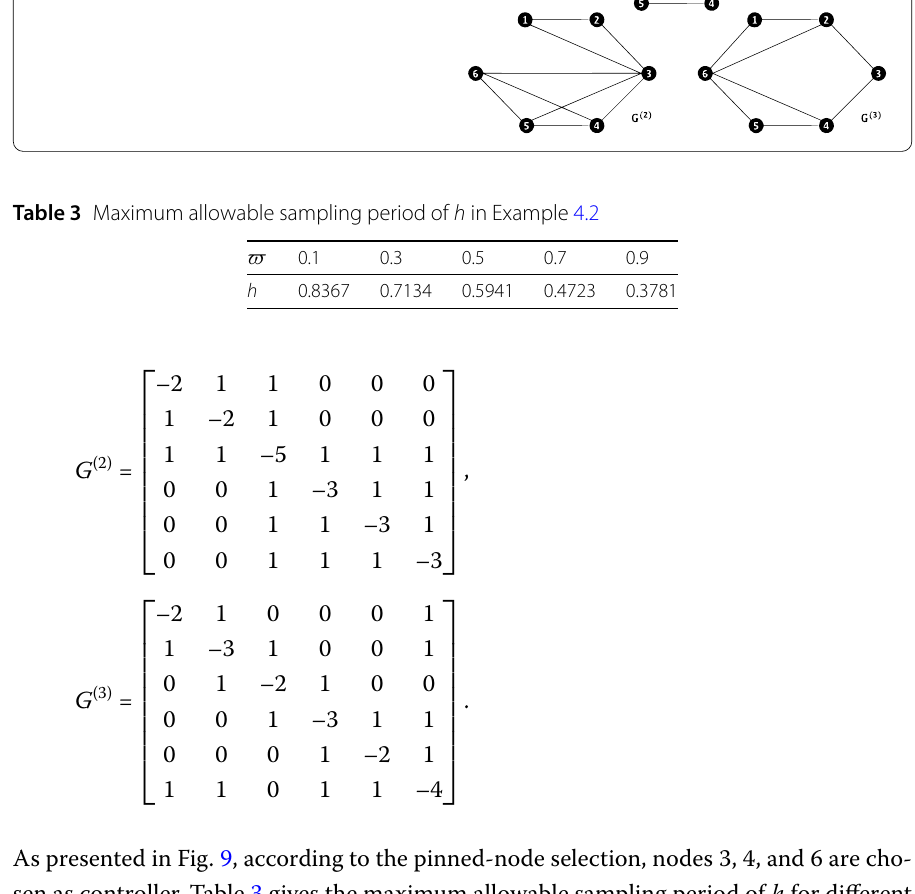
Figure 9 Simple undirected neural networks with six nodes